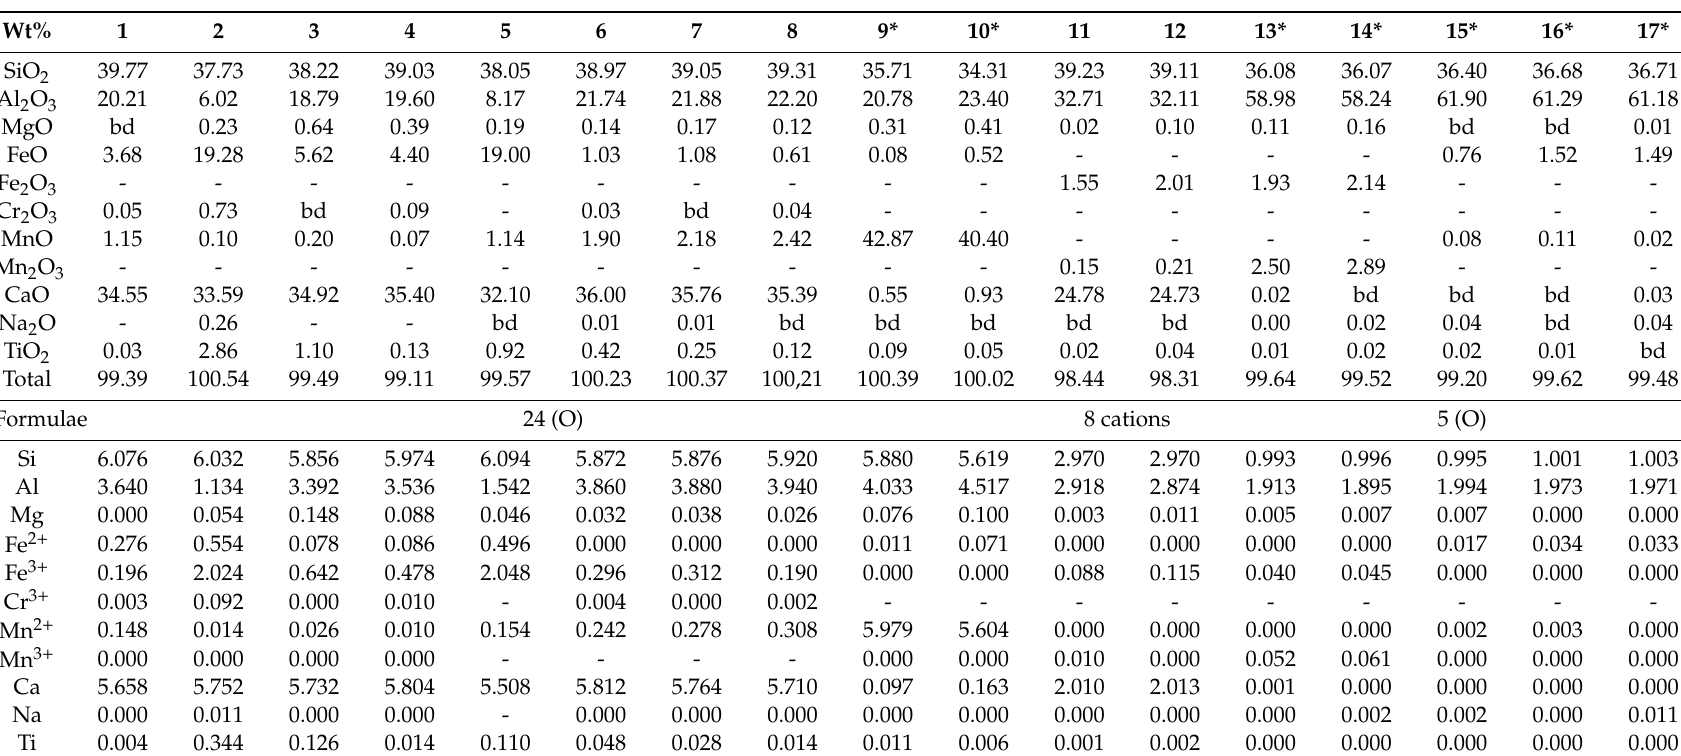
Table 2. Representative EPMA of various gem-quality minerals from Greece: Andradite-grossular, Kimmeria (1–2); Andradite-grossular, Maronia (3–4); Andradite-Grossular, Kos Island (5); Grossular, Thassos (6–8); Spessartine, Thassos (9–10); Zoisite, Thassos (11–12); Mn-andalusite, Thassos (13–14); Orange kyanite, Thassos (15–16); Blue kyanite, Thassos